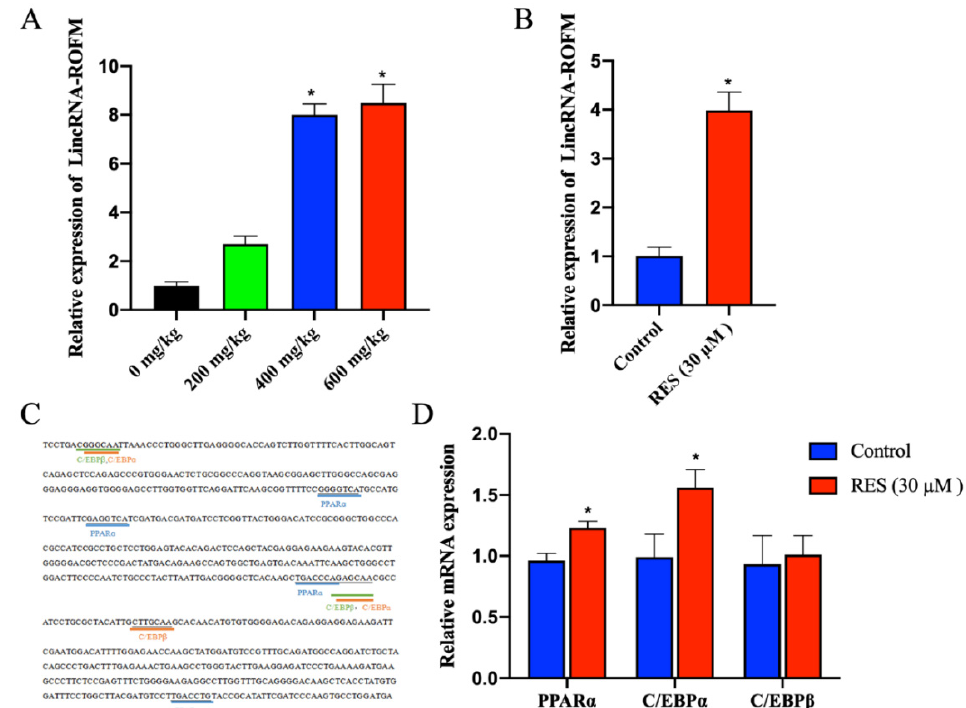
Figure 8. RES can regulate the expression of LincRNA-ROFM by PPAR α and C/EBP α . ( A ) The expression profiles of LincRNA-ROFM in porcine subcutaneous fat in 0 mg/kg, 200 mg/kg, 400 mg/kg, and 600 mg/kg RES groups as detected by RT-qPCR assay. ( B ) The expression profiles of LincRNA-ROFM in porcine preadipocytes treated with RES (30 μ M) as detected by RT-qPCR assay. ( C ) Predicting the transcription factor binding site on the LincRNA-ROFM promoter region. ( D ) mRNA expression levels of PPAR α , C/EBP α , and C/EBP β in porcine preadipocytes treated with RES (30 μ M) as detected by RT-qPCR assay. Data are presented as the mean ± SEM (n = 3) vs. control, * p < 0.05 , .